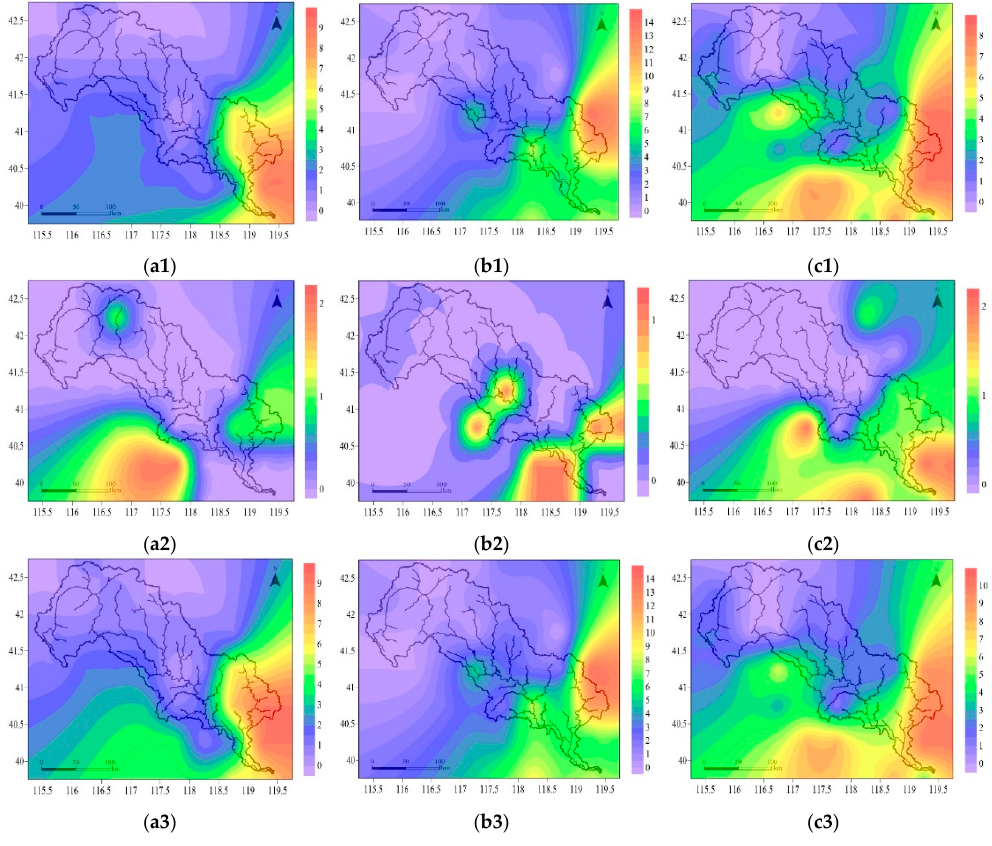
Figure 4. Distribution of drought–flood abrupt alternation events from 2020 to 2050 in the Luanhe River Basin: In summer under RCP2.6 ( a1 ), RCP4.5 ( b1 ), and RCP8.5 ( c1 ); in spring and autumn under RCP2.6 ( a2 ), in autumn under RCP4.5 ( b2 ) and RCP8.5 ( c2 ); in whole year under RCP2.6 ( a3 ), RCP4.5 ( b3 ), and RCP8.5 ( c3 ). RCPs represent the Representative Concentration Pathways. The color bars represent the occurrence frequency of drought–flood abrupt alternation events, for example, the purple means the frequency is zero.